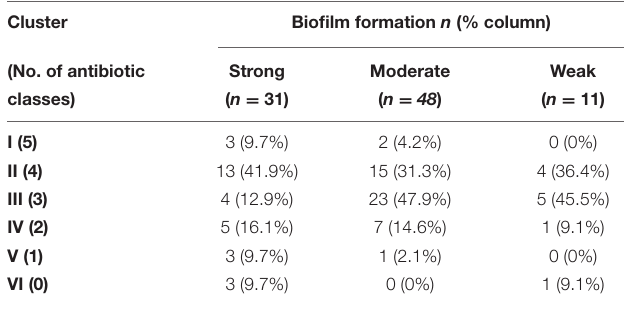
TABLE 2 | Distribution of biofilm forming-abilities of Acinetobacter baumannii isolates among different antibiotic-resistance clusters. Cluster Biofilm formation n (% column) (No. of